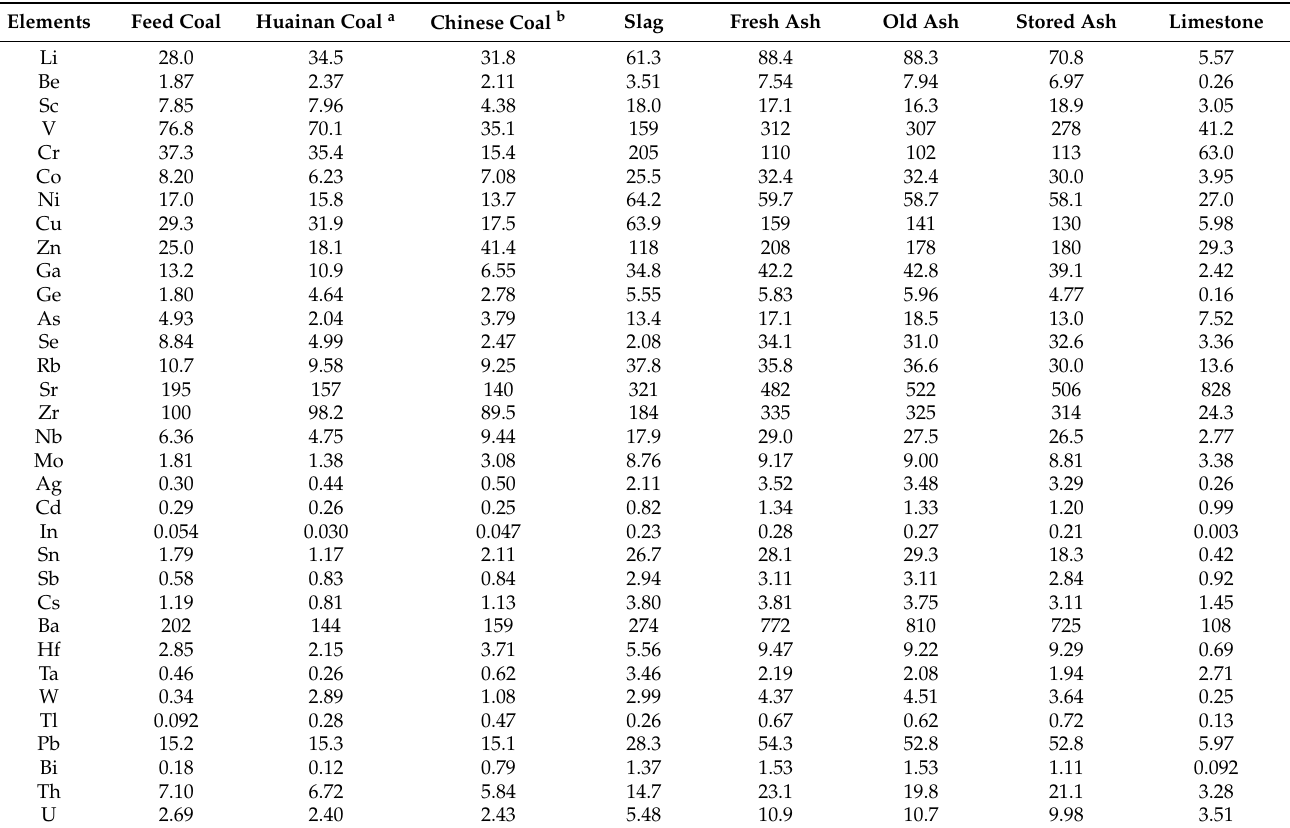
Table 4. Trace element concentrations in feed coal and its by-products from the TY power plant (units: mg/kg on air-dried